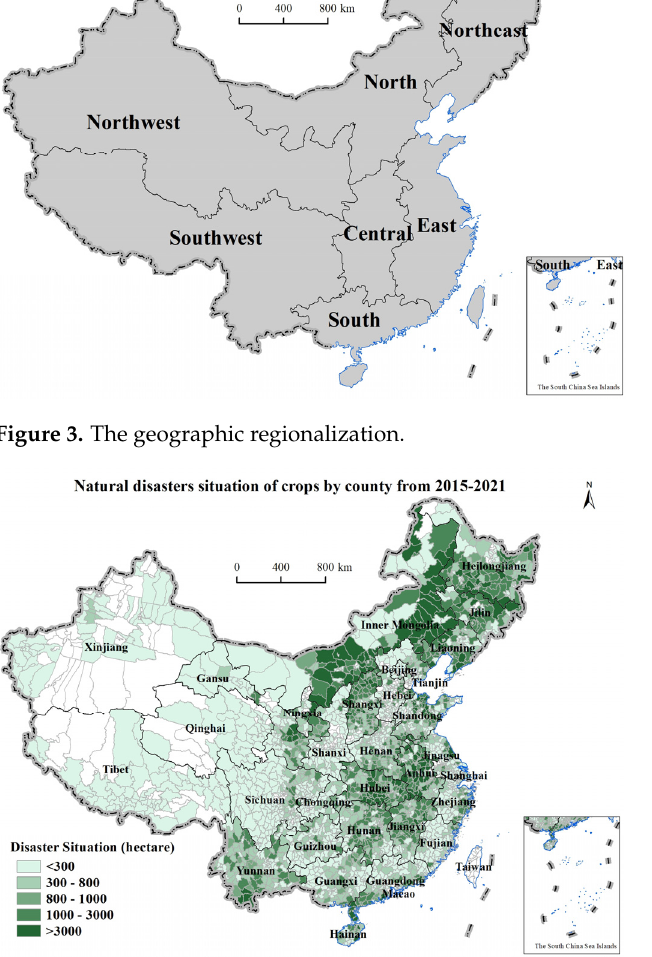
Figure 4. Natural disasters situation of crops by county from 2015–2021.